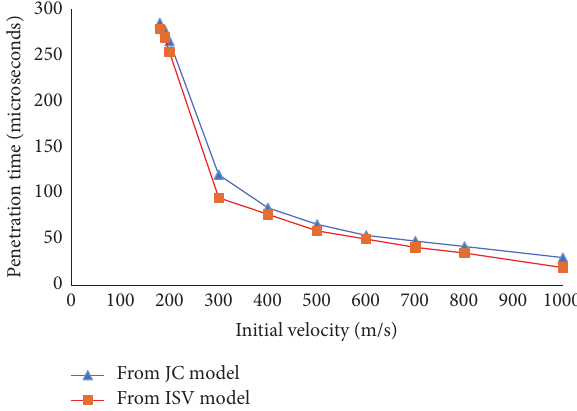
Figure7:InitialvelocityversuspenetrationtimecurvesfromJCand ISV